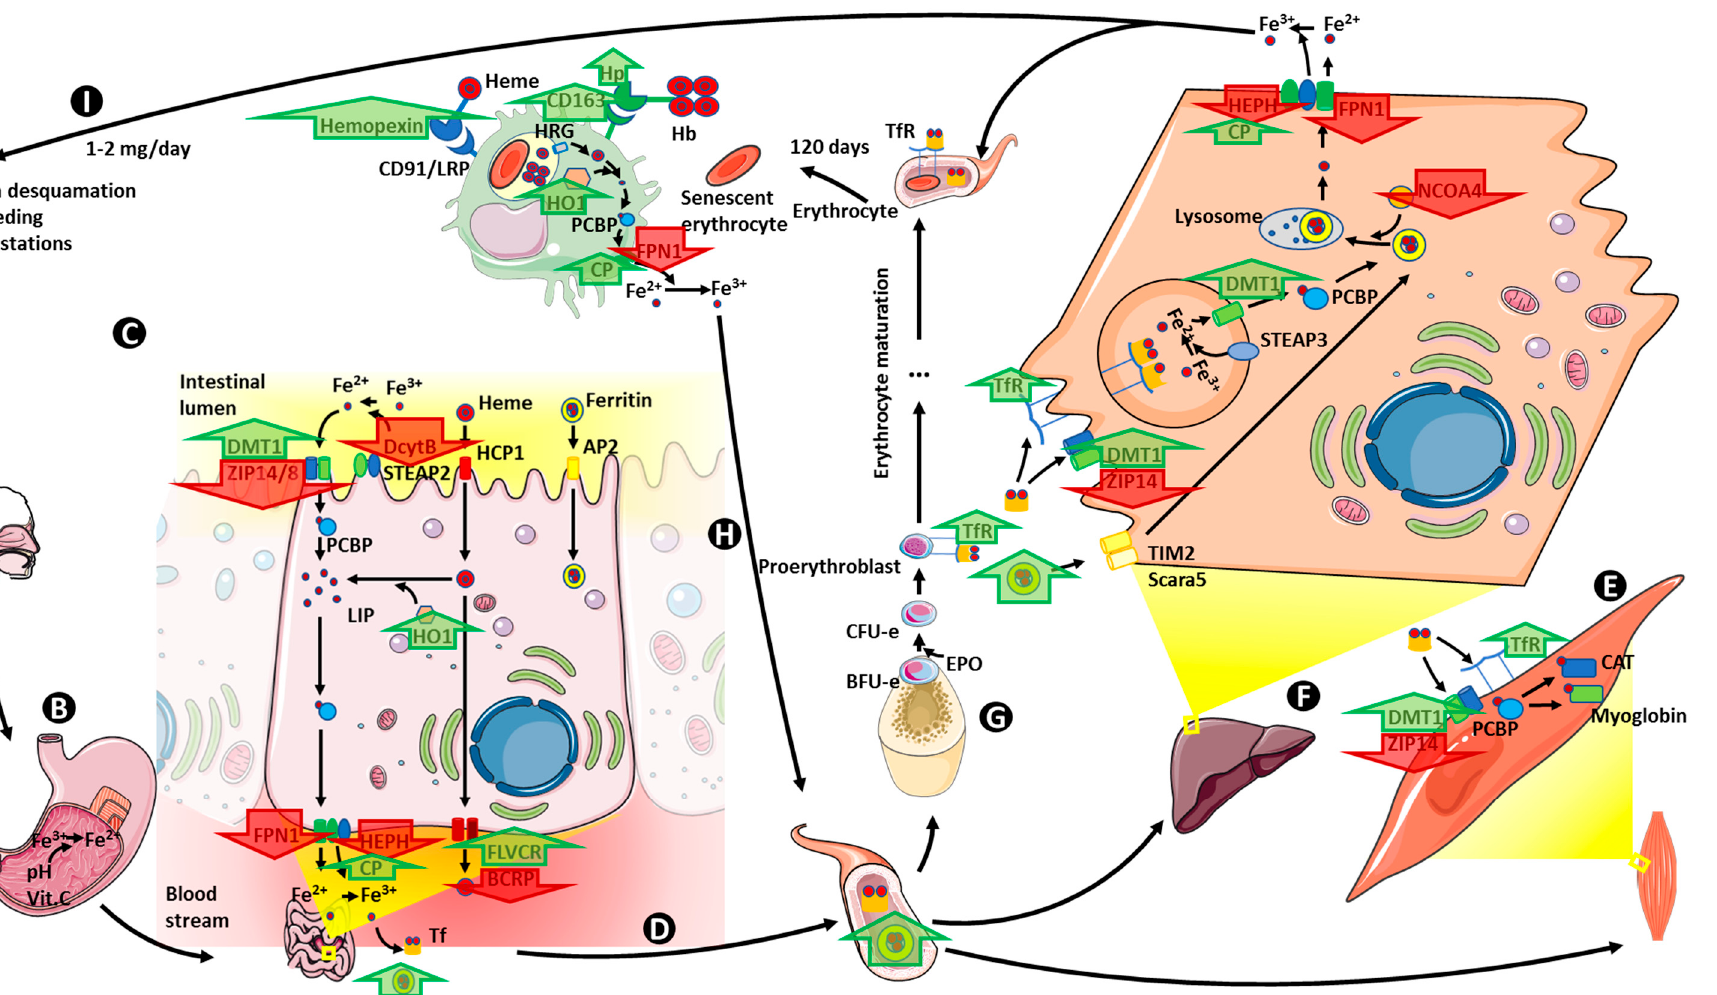
Figure 3. Iron metabolism dysregulation in obesity. Obesity influences iron metabolism at many steps of the cycle. No alterations have been proven in iron ingested from the diet ( A ), nor in its reduction from Fe 3+ to Fe 2+ in the stomach ( B ). In the duodenum enterocytes in obese patients, DMT1 density increases at the apical membrane, whereas ZIP14 and 8 co transporters decrease. HO1 levels increase intracellularly and at the basal membrane CP and FLVCR increase, whereas FPN1, BCRP and HEPH decrease ( C ). Ferritin circulating levels increase ( D ). Myocyte and hepatocyte transferrin receptor density increases, together with an increase